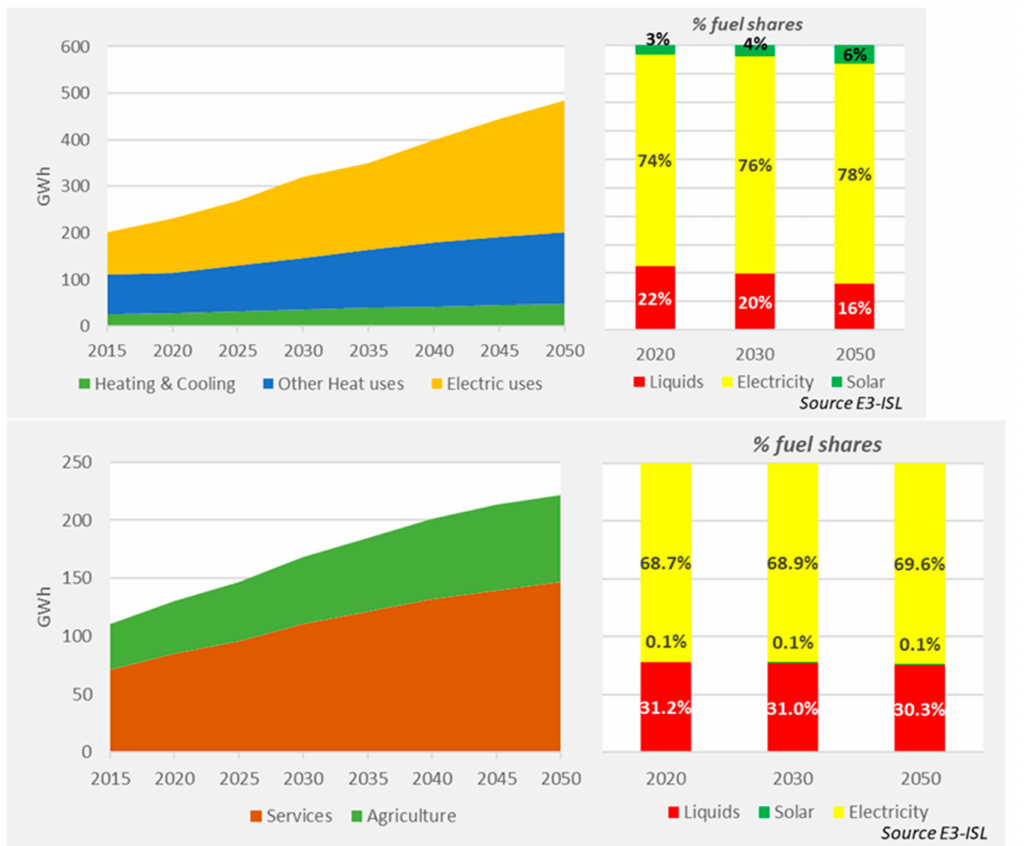
Figure 3. Baseline scenario—top: final energy consumption in residential sector by end-use and fuel mix for the period 2020–2050; bottom: final energy consumption in tertiary sector by sub-sector and fuel mix for the period